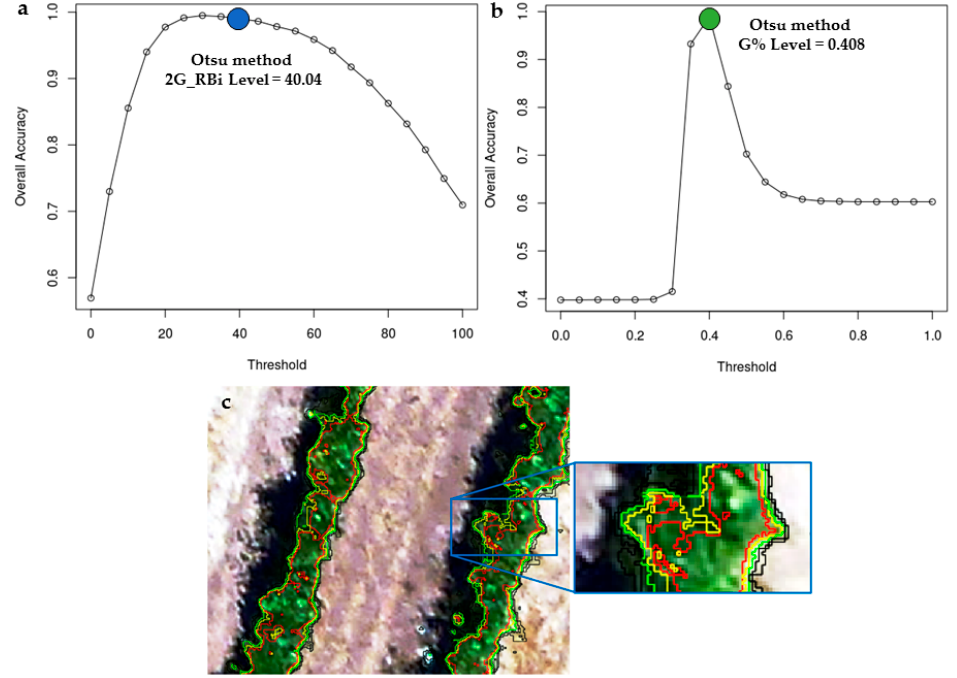
Figure 1. Example of the comparison between overall accuracy and threshold values for Spectral indices. ( a ) Difference index (2G_RBi); ( b ) Green percentage index (G%) and ( c ) Visual interpretation of thresholding process of 2G_RBi for Plant class. Values below 40 are shown in black, equal to 40 in green, 50 in yellow and 60 in red.